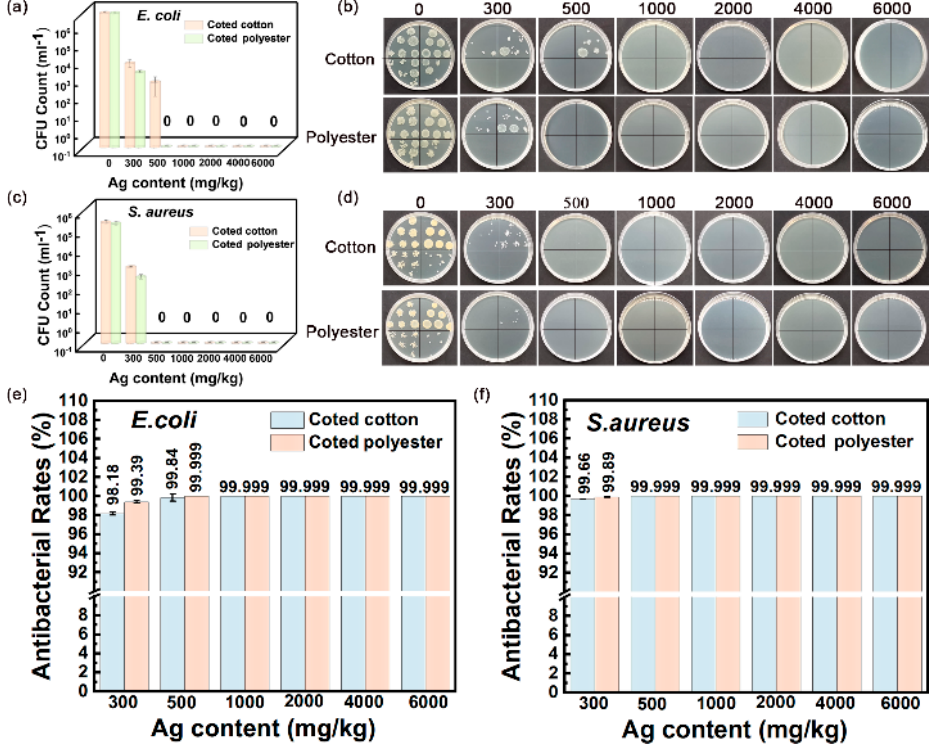
Figure 10. Antibacterial activities of nanosilver-glue-coated cotton and polyester fabrics against E. coli and S. aureus for 50 cycles of standard washing. ( a , b ) Corresponding photos of E. coli and S. aureus colonies in culture dishes. ( c , d ) CFU counts of cotton and polyester fabrics after incubation. ( e , f ) Antibacterial rates of coated cotton and polyester fabrics against E. coli and S. aureus .